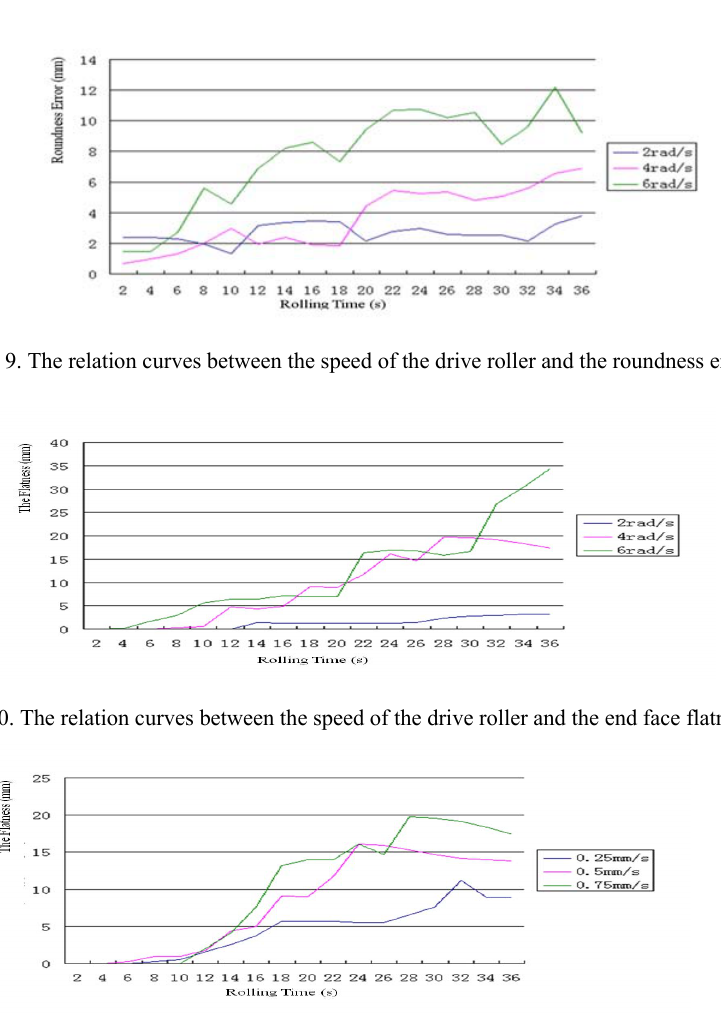
Fig. 11. The relation curves between the feed speed of the taper roller and the end face